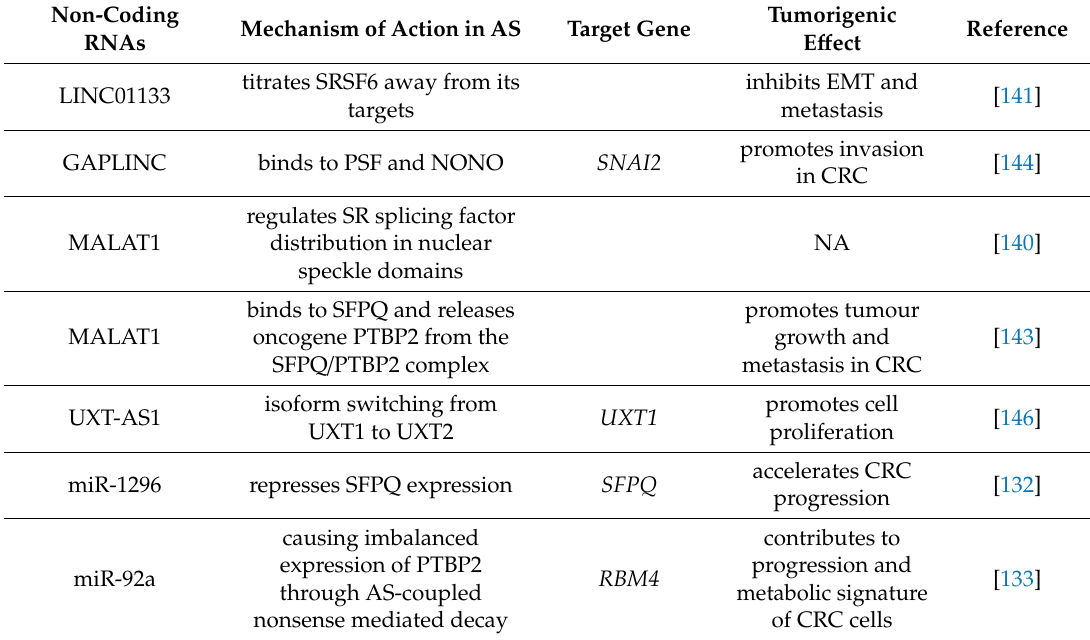
Table 3. List of noncoding RNAs regulating alternative splicing in CRC.